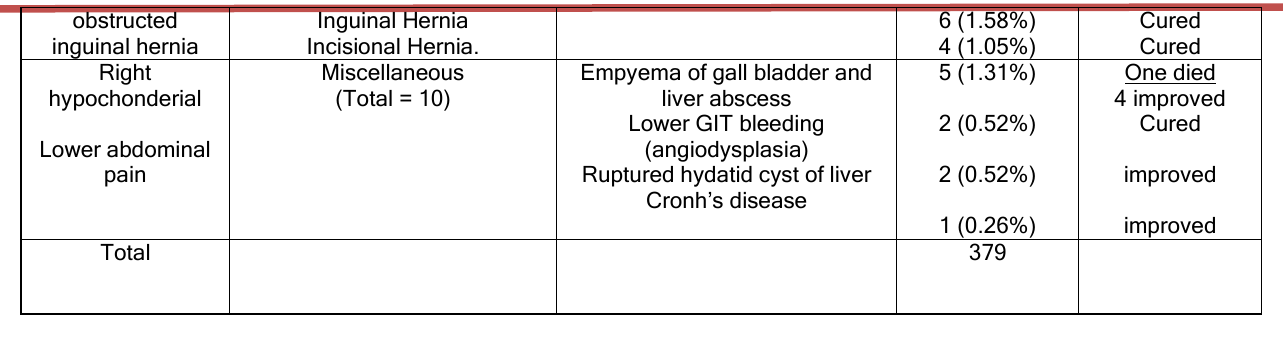
Table (3): Site of pain and final diagnosis in patients treated conservatively.